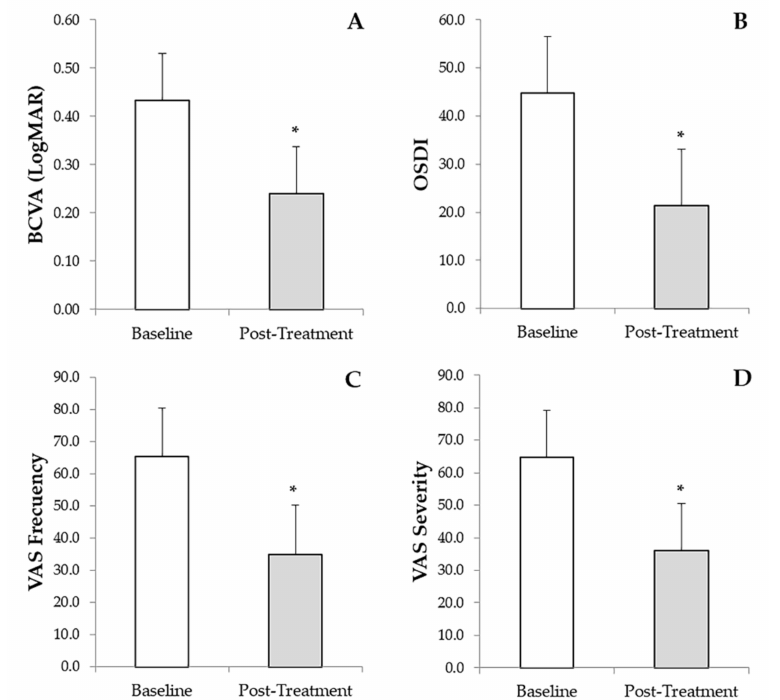
Figure 2. Results of the secondary outcome measured before and after treatment with PRGF eye drops and RGTA. ( A ): Best- corrected visual acuity (BCVA). ( B ): Ocular surface disease index (OSDI). ( C ): Visual analog scale (VAS) frequency, and ( D ): VAS severity. * Statistically significant differences ( p < 0.05) before versus after treatment with PRGF and